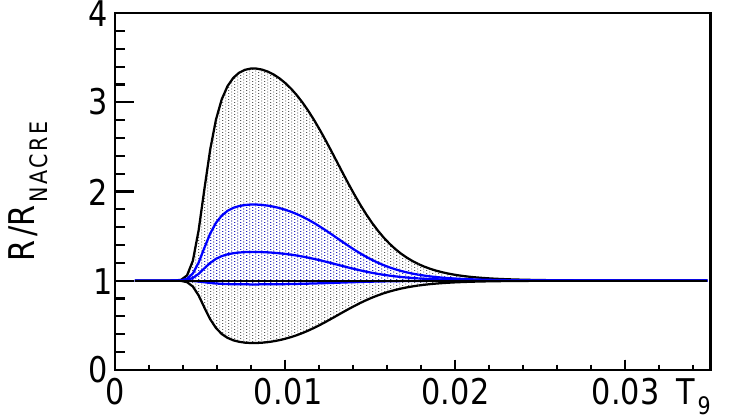
Figure 4. Comparison of the THM reaction rate (black lines) of the 18 O(p, α ) 15 N reaction with the NACRE one [82] (blue lines). The full lines are the ratio of the recommended rate to the NACRE one. The blue dotted area marks the reaction-rate interval allowed by the THM experimental uncertainties, while the black dotted area is used to display the uncertainty range characterizing direct data